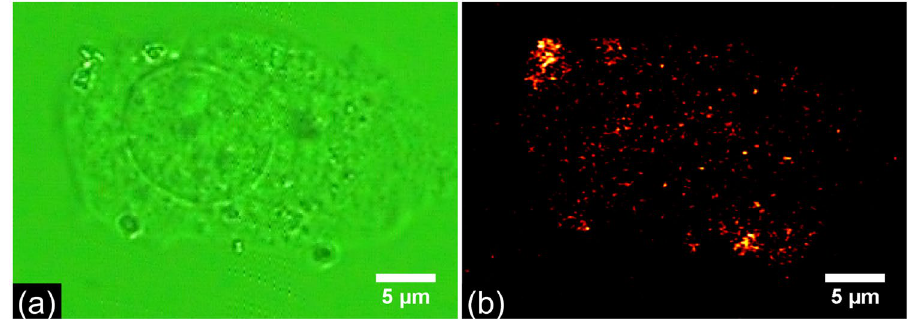
Figure 4. ( a ) Wide field image of the HeLa cell with PLL coated 20 nm BaTiO 3 nanoparticles. ( b ) Corresponding 3D image of HeLa cells made from different axial sections of 2 μ m interval taken with two- photon photothermal microscope. Pump and probe powers used are 3 mW and 0.8 mW respectively at the sample.